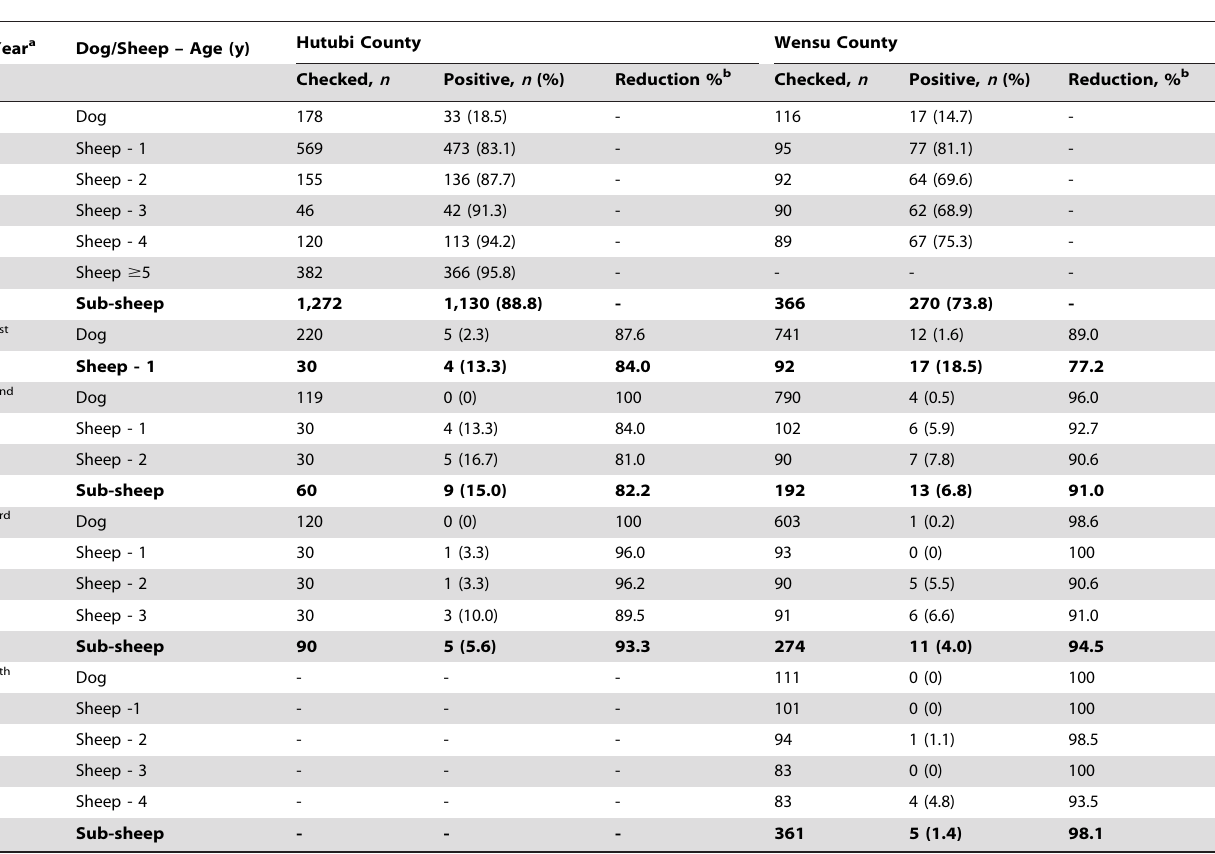
Table 2. Efficacy of the pilot program for cystic hydatid disease control using dogs and sheep as markers of Echinococcus granulosus infection after monthly treatment of dogs with praziquantel in Hutubi County (1987–1990) and Wensu County (1990– 1994), Xinjiang,